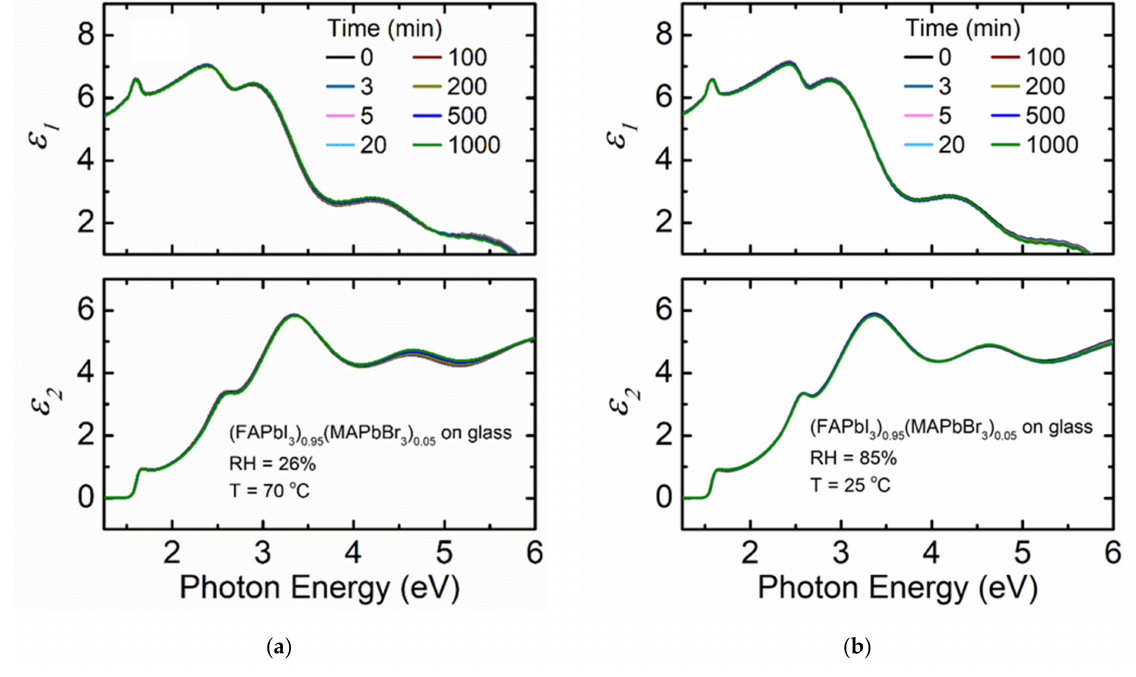
Figure 8. Spectra in ε at selected time points for thin film (FAPbI 3 ) 0.95 (MAPbBr 3 ) 0.05 deposited on a soda lime glass as a function of photon energy when exposed to ( a ) 26% RH at 70 ◦ C and ( b ) 85% RH at 25 ◦ C. RH is introduced at 5